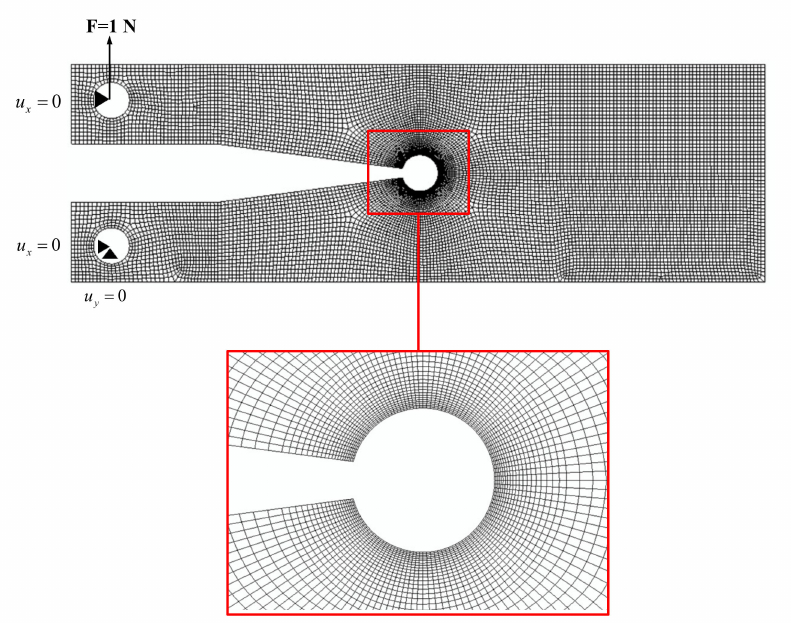
Figure 2. FE model and mesh pattern for DCB 1 specimen near the VO-notch tip ( ρ = 1 mm, γ = 15 ◦